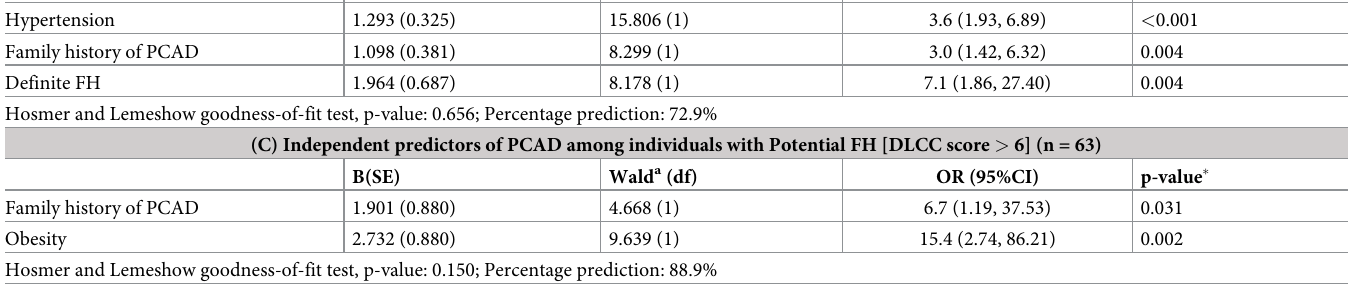
The final prediction model of PCAD among individuals with Potential FH were shown in Table 5(C) . Results show that Potential FH patients with family history of PCAD have 6.7 times the odds to develop PCAD compared to those who were not Potential FH. Besides, patients who were obese were 15.4 times more likely to develop PCAD compared to FH patients who were not obese.